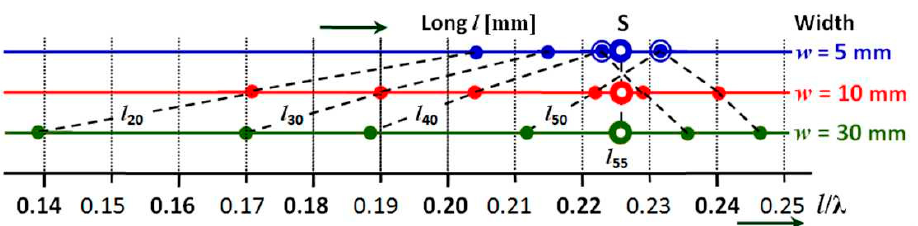
Figure 13. Concentrated distribution of the position of resonant points of a set of flat microwave antennas again showing the significant crossover point S .